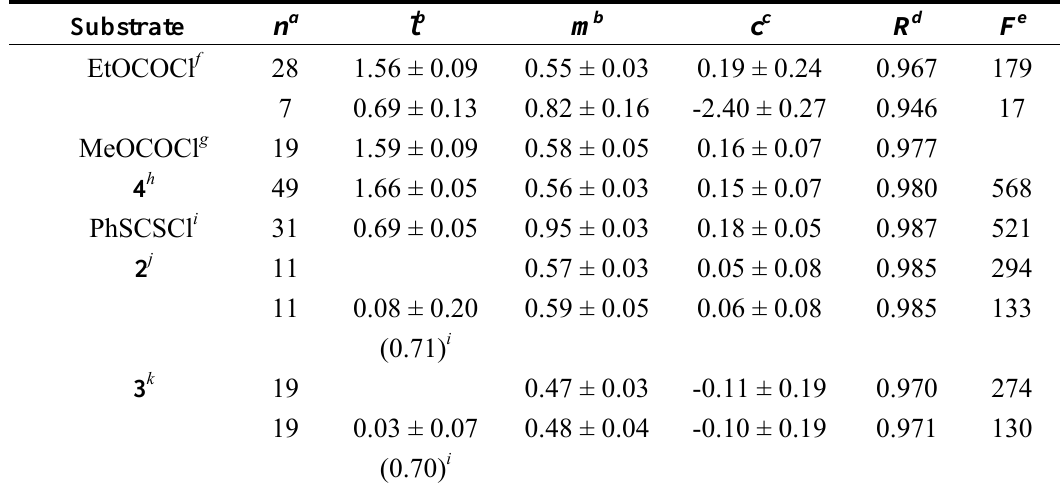
Table 4. Correlation of the specific rates of reaction of other chloroformate esters using the simple or extended Grunwald-Winstein Equations (Equations 1 and